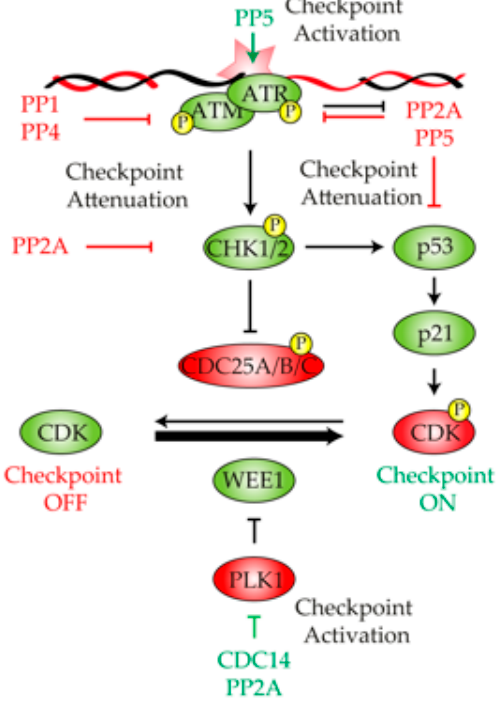
Figure 1. The diagram summarizes relevant information obtained from di ff erent model organisms, describing the role of protein phosphatases in the DNA damage checkpoint regulation. In response to DNA damage, phosphoprotein phosphatase 5 (PP5) collaborates in the activation of the DNA damage checkpoint by stimulating ATM / ATR activity, a process that triggers a phosphorylation cascade that end ups with the inhibition of the cyclin-dependent kinase (CDK). PP1, PP4 and PP2A restrain checkpoint activity by dephosphorylating ATM, ATR and p53, thus bu ff ering the intensity of the response. CDC14 collaborates in the activation of the DNA damage checkpoint by restraining the negative e ff ect that PLK1 exerts over the CDK inhibitor WEE1. Green and red indicate active or inactive,